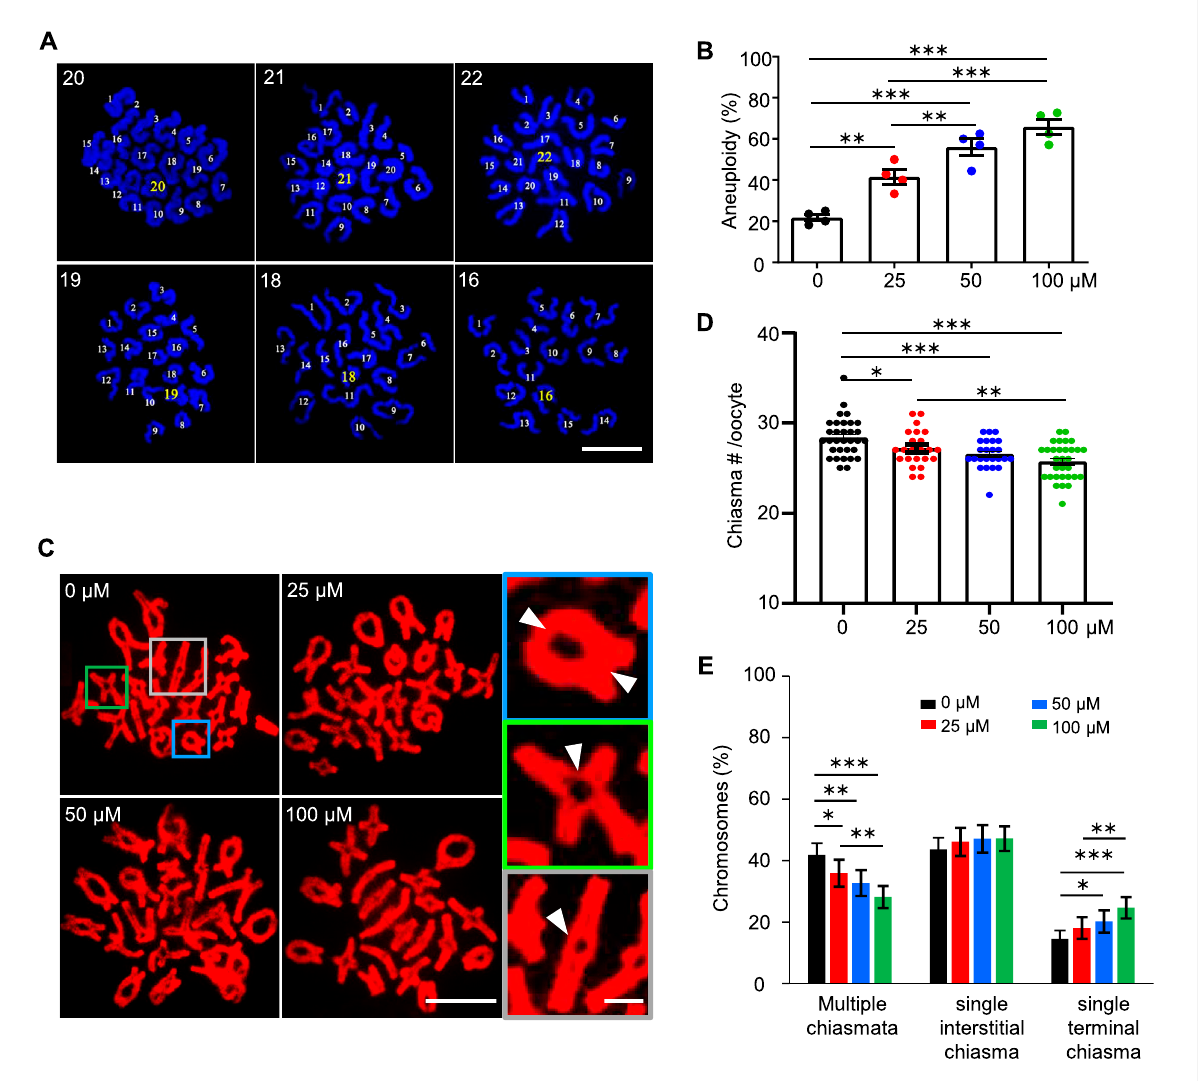
AAI exposure induces a high frequency of aneuploidy in mouse oocytes. (A) The GV oocytes were matured in the M16 medium with 0, 25, 50, and 100 μ M AAI for 12 h to reach MII. Representative images showing MII oocyte spread chromosomes with DAPI staining. The number of chromosomes in each nucleus was indicated. Scale bar, 10 μ m. (B) Quanti fi cation of aneuploidy frequency in (A) . 8 – 17 MII oocytes per treatment in each experiment. Totally, 51, 35,46, and 33MII oocyteswereexamined in0, 25, 50, and 100 μ MAAI treatments, respectively. Error bar, mean± SEM of 4 independent experiments. (C) The GV oocytes were matured in the M16 medium with indicated AAI concentrations for 8 h to reach metaphase I (MI). Representative images showing MI oocyte spread chromosomes stained with PI. Scale bar, 10 μ m. At MI, chiasmata connect the homologous chromosomes. The enlarged pictures on the right show the homologous chromosomes connected with 2 chiasmata (top), a single interstitial chiasma (middle), orasingleterminal chiasma (bottom). White arrowheads indicating thepositionsof chiasmata. Scale barin theenlarged picture, 5 μ m. (D) Quanti fi cation of chiasmata numbers per nucleus in (C) . 32, 23, 24, and 31 MI oocytes from 0, 25, 50, and 100 μ M AAI treatments, respectively. Error bar, mean ± SEM. (E) Quanti fi cation of the proportions of chromosomes with different classes of chiasmata in (C) . 640, 460, 480, and 600 MI homologous chromosomes from 0, 25, 50, and 100 μ M AAI treatments, respectively. Error bar, 95% con fi dence interval. Only comparisons withsigni fi cantdifferenceswereindicated; *, p < 0.05;**, p < 0.01; ***, p < 0.001 (B,D,E) ;one-way ANOVAand theLSDtest (B,D) ;Chi- square (E)